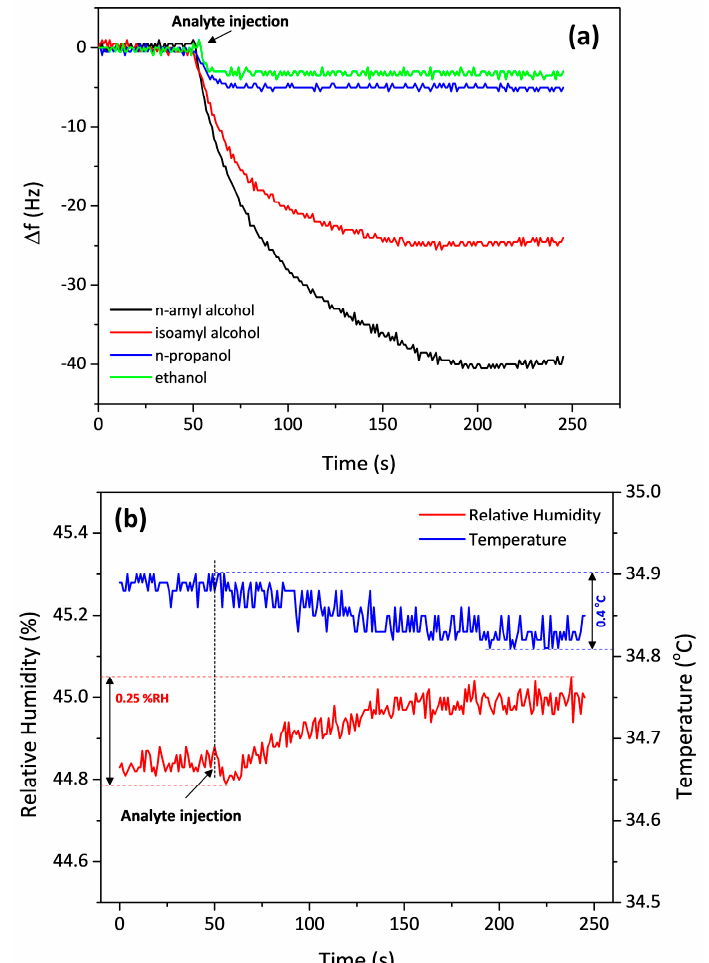
Figure 4. ( a ) Frequency shift of the chitosan-based QCM sensing system after contact with alcohols at 7 mg · L − 1 and ( b ) the drift of RH and temperature of the sensing chamber throughout the measurement.